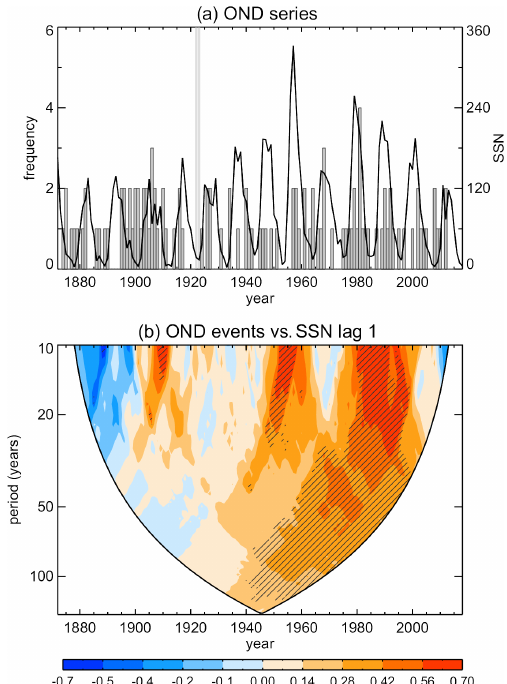
Figure 9. (a) Time series of the autumn frequency of independent daily mean detrended water height (IDMWH) extremes for 1872– 2018, defined as daily peaks above the 99.5th percentile (35.0cm) of the total distribution for the period 1924–2018. Daily peaks are required to be separated by more than 72h. The black line shows the autumn mean time series of the sunspot number (SSN). Bot- tom panel: rank Spearman’s ( r ) correlations between the autumn frequency of independent daily mean detrended water height ex- tremes and the SSN for running windows of different width ( y axis) centred at each year of the 1872–2018 period ( x axis). Hatching denotes statistically significant correlations ( p< 0 . 05). Correlations are only computed when the sample size is equal to or larger than 10, and it exceeds the half size of the window. Panel (b) shows the correlation pattern for SSN leading by 1 year, which produces the largest values. Data sources: World Data Center Sunspot Index and Long-term Solar Observations (WDC-SILSO), Royal Observatory of Belgium, Brussels (see Clette et al., 2014), and Raicich (2015). This figure follows the same approach adopted in Barriopedro et al. (2010), which considered the much shorter 1948–2008 period and the frequency of meteorological surge